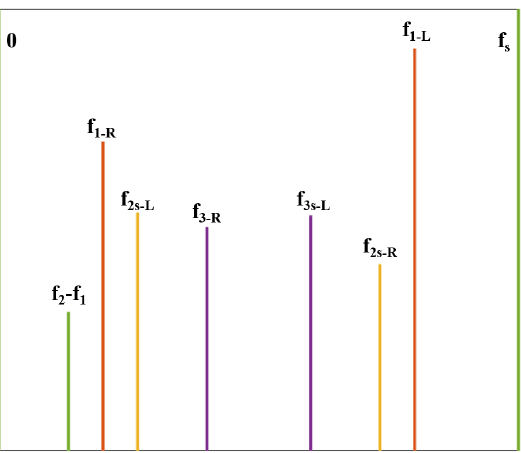
Figure 6. Spectrum diagram of the beat frequency signals after a PD and an